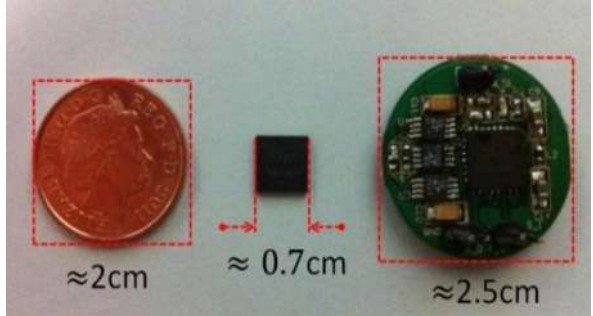
Figure 9.the output result of the chip using